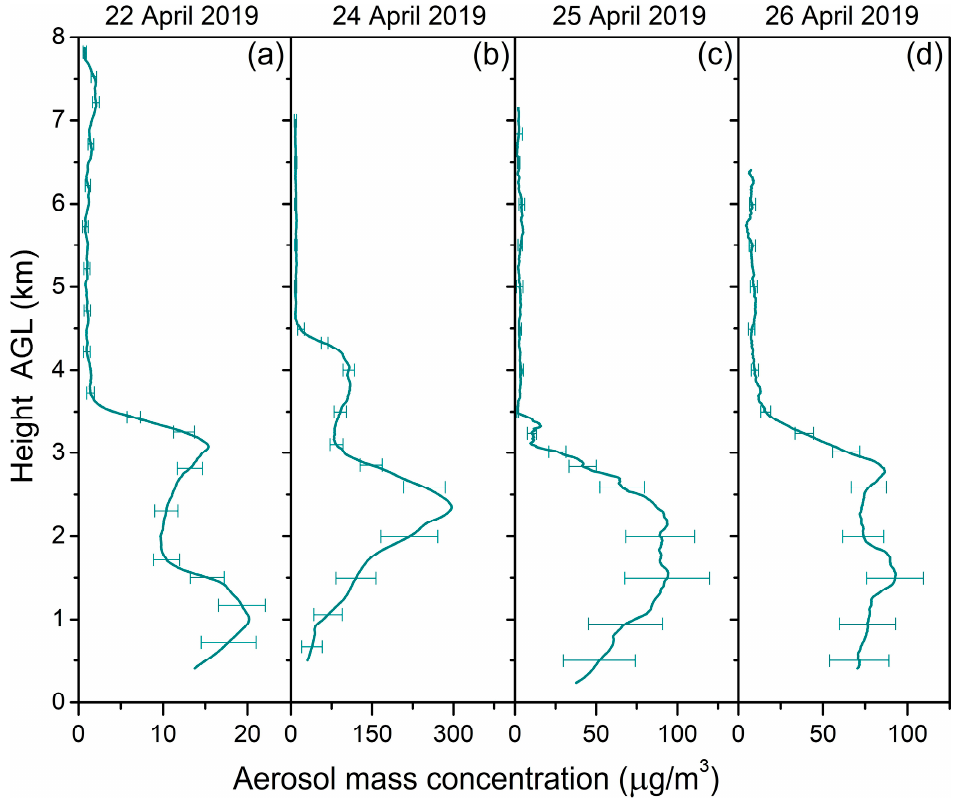
Figure 12. Vertical profiles of the aerosol/dust mass concentration determined by the combined use of data from lidar and in situ